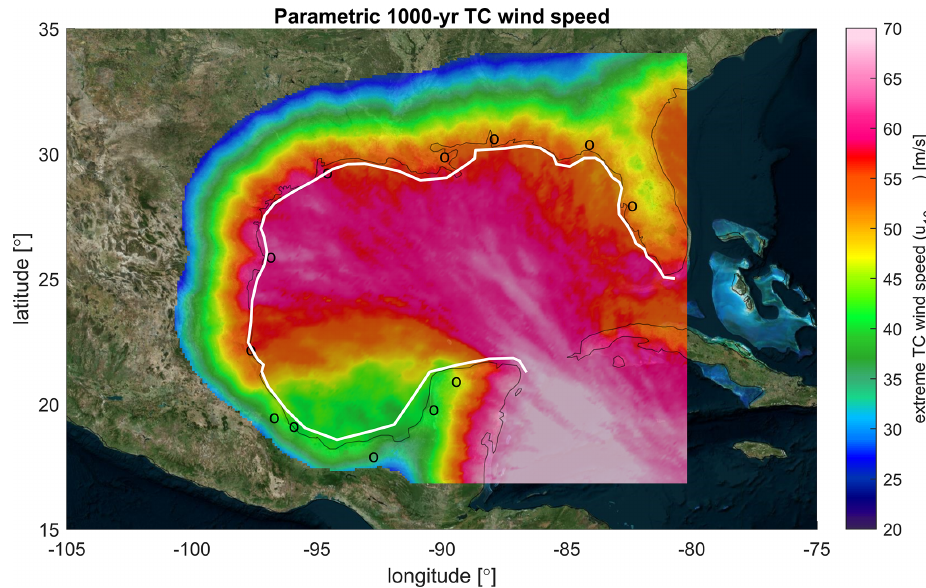
Figure 12. Model estimates for the parametric empirical estimate of 1000-year TC wind speed return values based on extreme wind speeds based on 10000 years of TCWiSE computations. All wind speeds are in meters per second, 10min averaged and determined at a 10m height. Black dots are the location of cities as plotted in Figs. 10 and 13. © Microsoft Bing Maps.